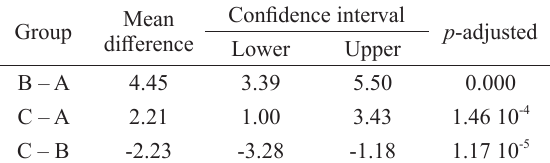
Differences in crab density (ind.m -2 ) among the groups of mangrove areas (A, Areas 01-03; B, Areas 04-08 and 12; and C, Areas 09-11) using information of Tukey